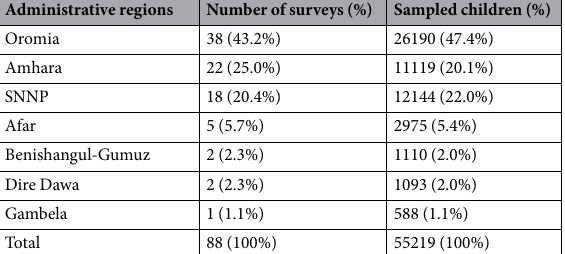
Table 1. Description of the 88 small-scale mortality surveys from Ethiopia, 2009–2014. SNNP: Southern Nations, Nationalities and People.